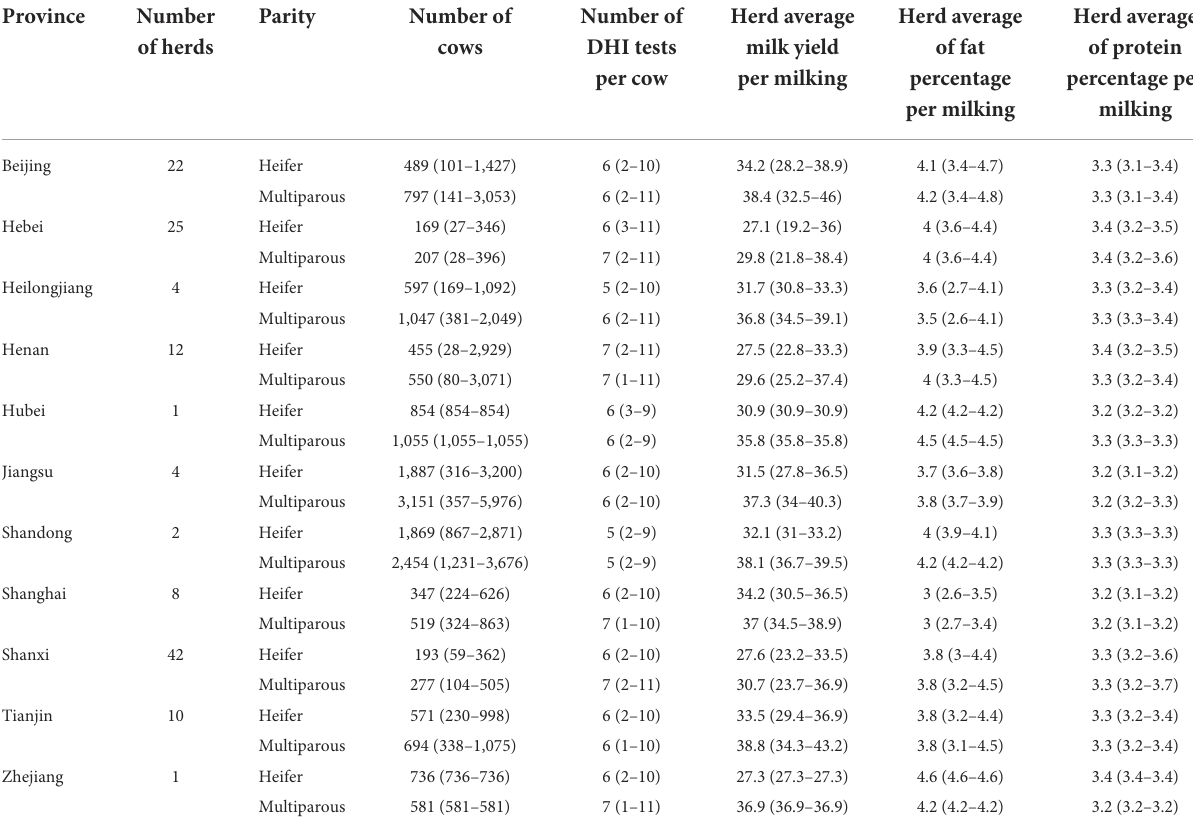
TABLE 1 Descriptive statistics of the 131 farms in 11 provinces in 2019 in the final dataset.